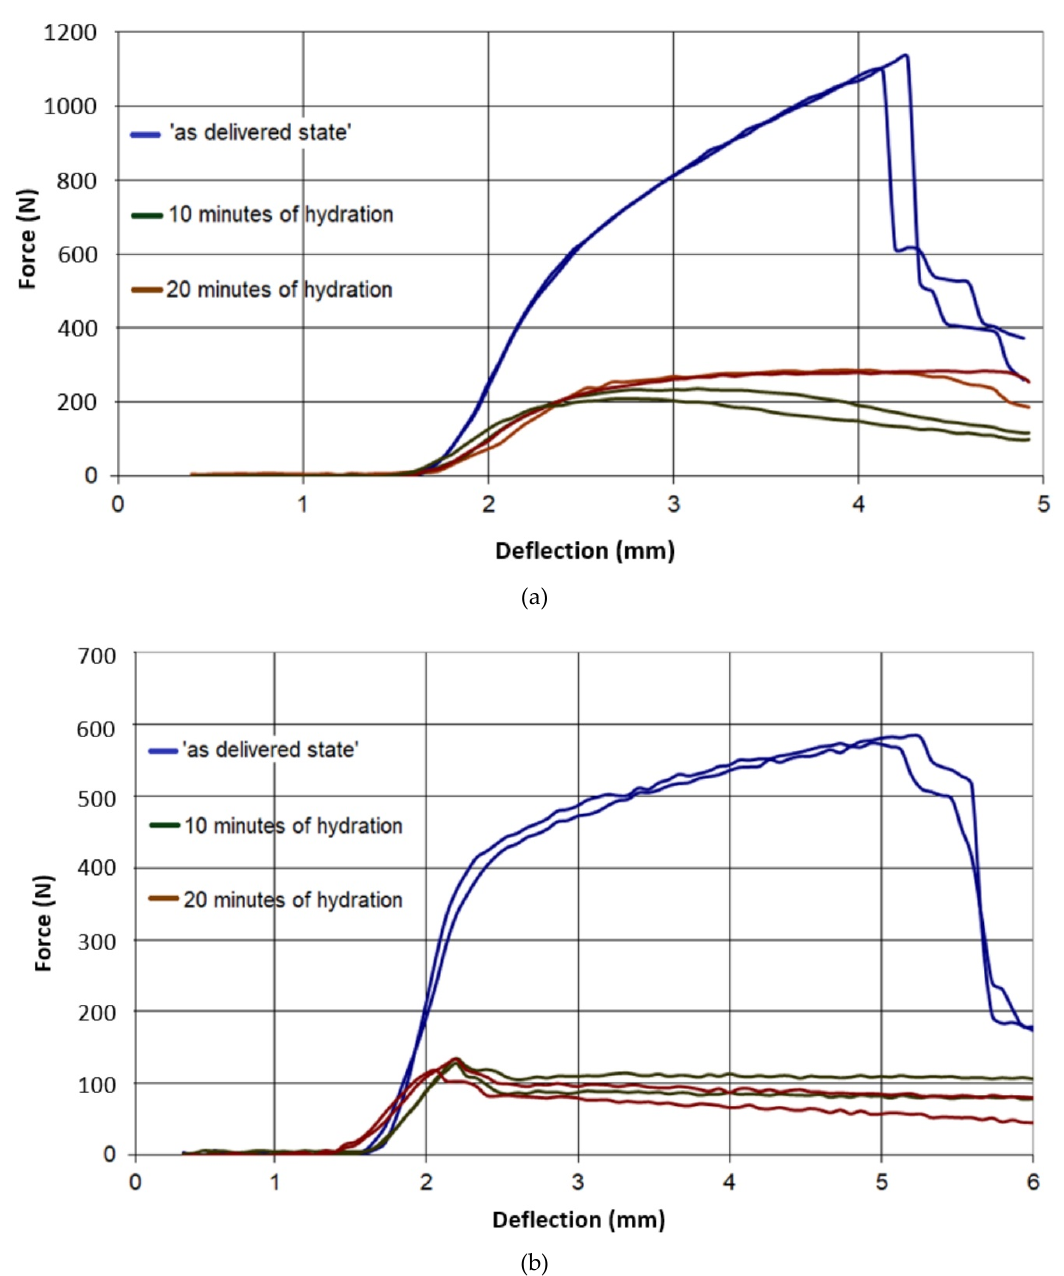
Figure 9. Force–deflection curves of the tested specimens of type G, ( a ) parallel to the sheet production direction, ( b ) perpendicular to sheet production direction.